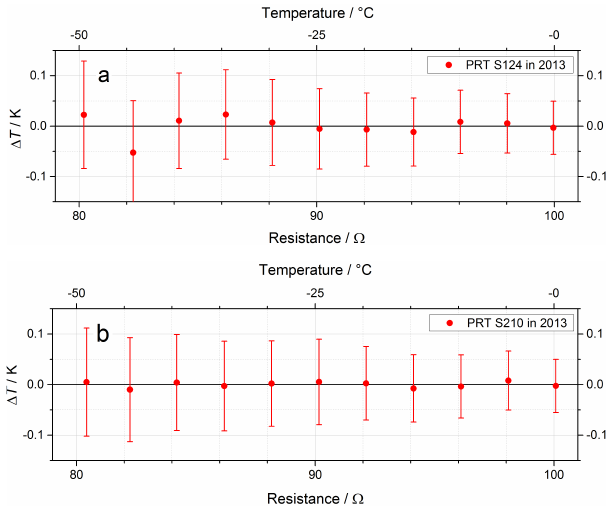
Fig. 12. Deviation (residuals) of the measured radiation temperature from the calibration curve at the measured resistance values (corre- sponding to temperature steps of 5 ◦ C from − 50 ◦ C to 0 ◦ C) for two selected PRTs. (a) PRT S124 (GBB-C), which showed the largest deviation of a calibration point from the fitted calibration curve in the January 2013 calibration campaign. (b) PRT S210 (GBB-H), which showed the smallest deviation of all calibration points from the fitted calibration curve in the January 2013 calibration cam-